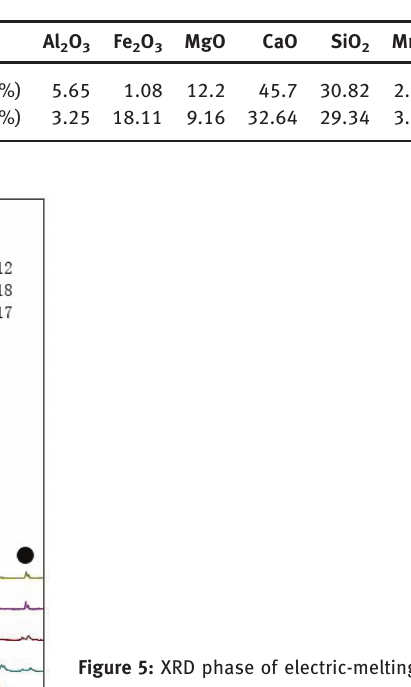
Table 5: Composition and content of the slag in the slag